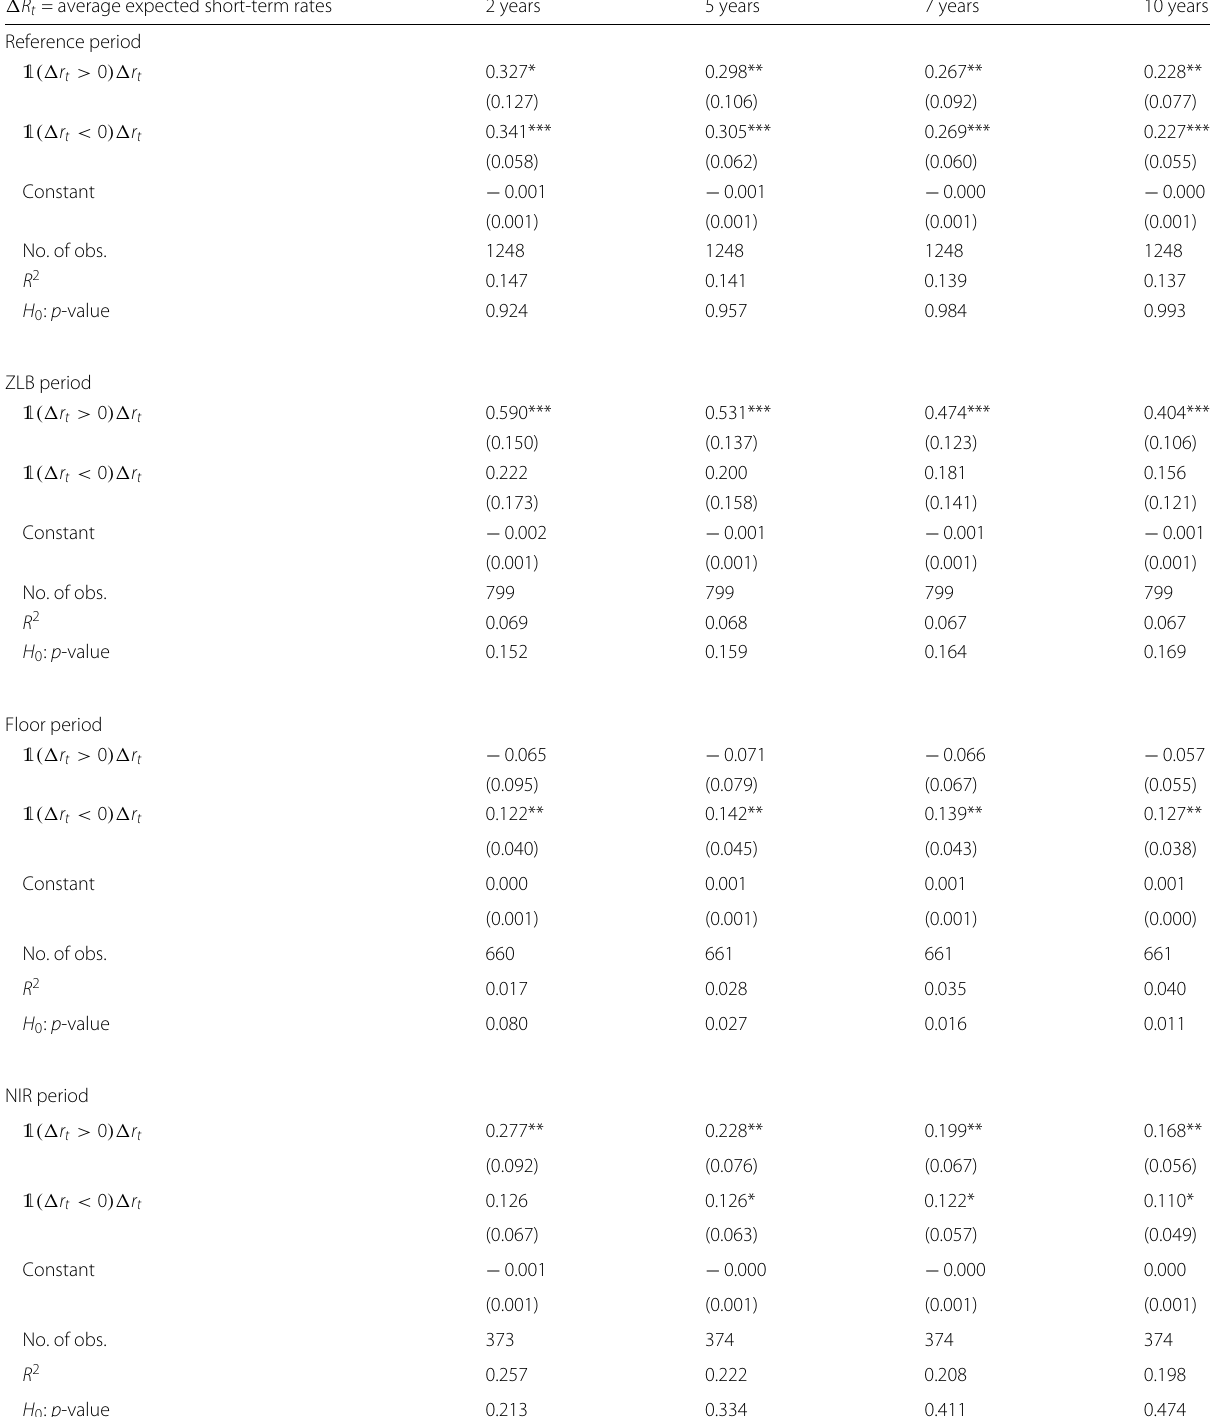
Table 5 Robustness: average expected short-term rates and additional control variables (cid:2) R t = average expected short-term